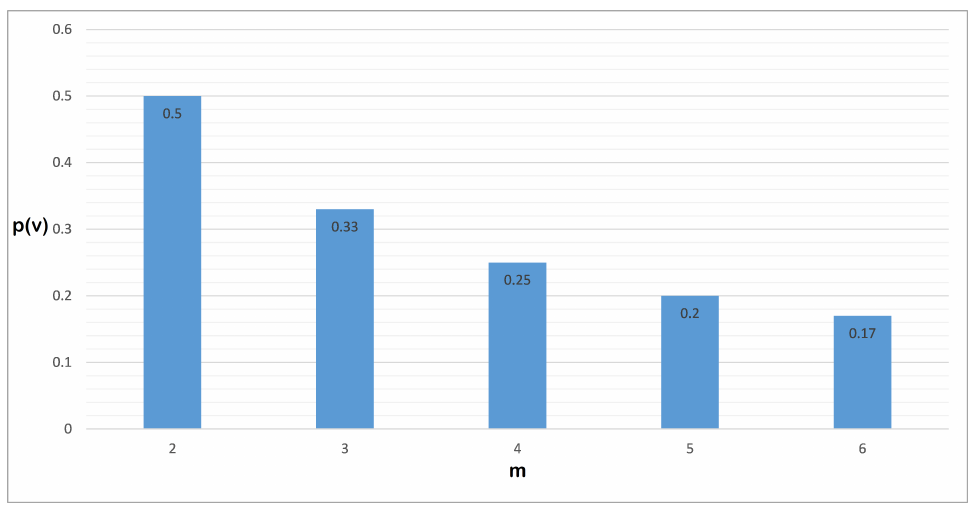
Figure 7. Probability of validating nodes.